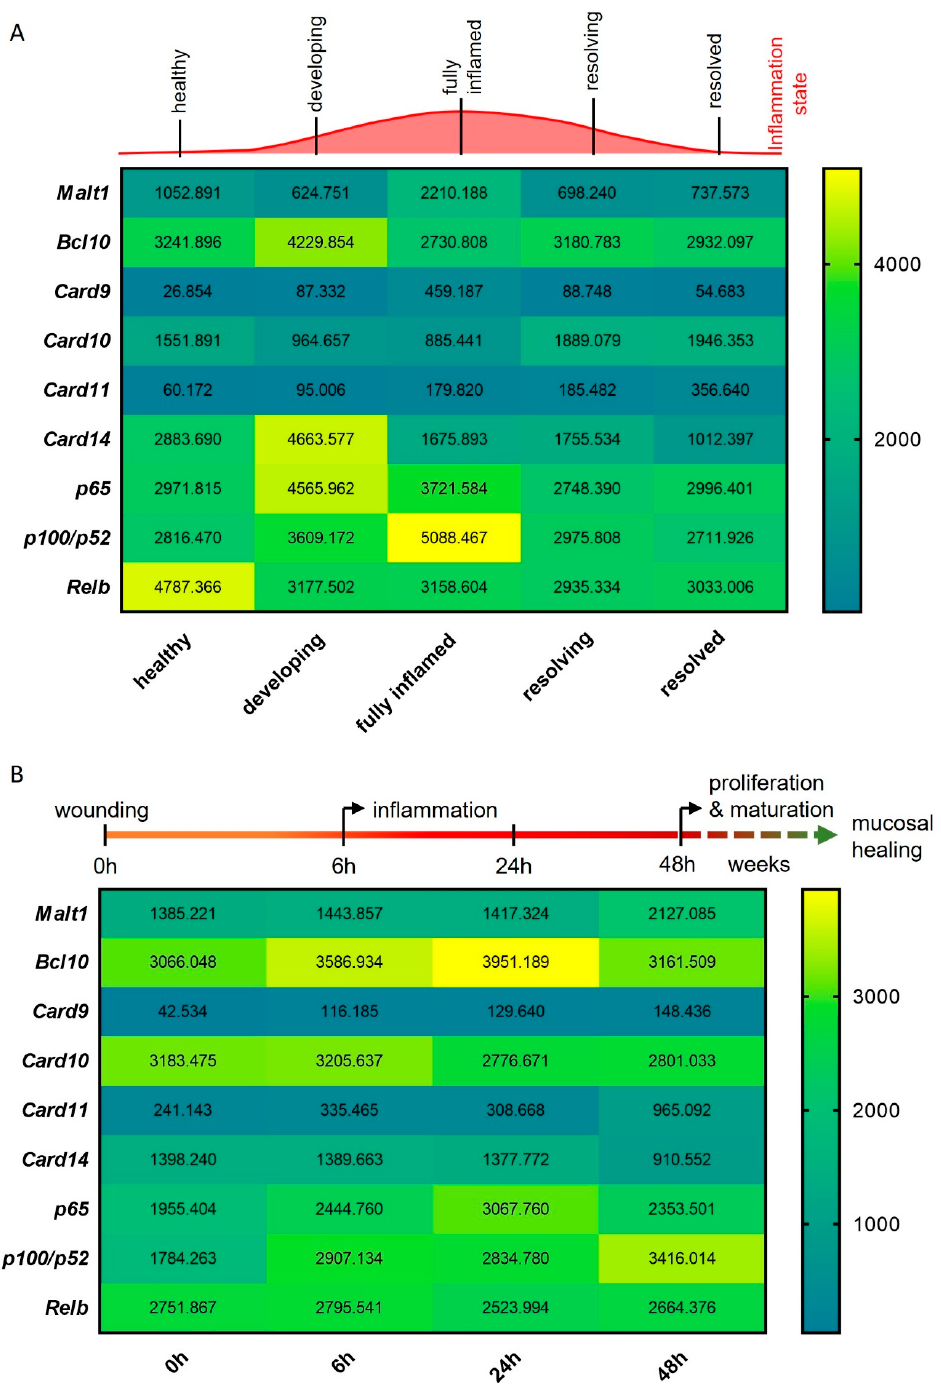
Figure 2. MALT1-mediated signaling is activated during experimental colitis and epithelial damage.